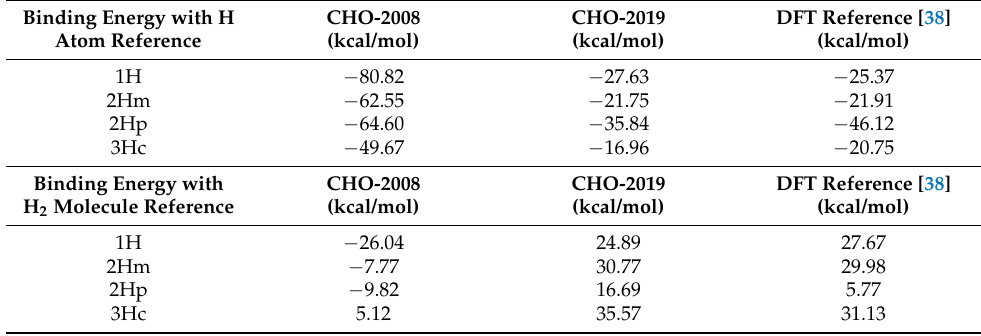
Table 1. Single-sided hydrogenation energies for different configurations.